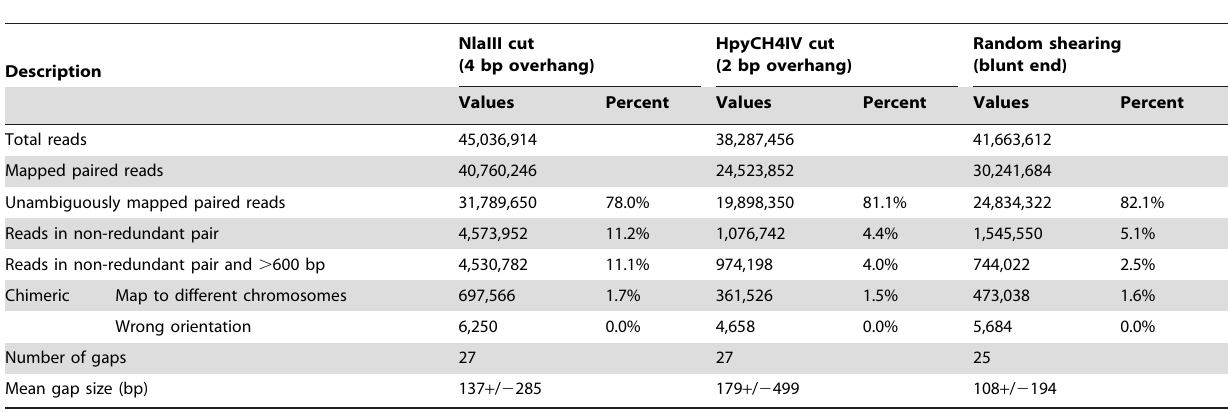
Table 3. Results from the alignment of Saccharomyces cerevisiae Illumina 22 kb CLIP-PE libraries to a reference genome.